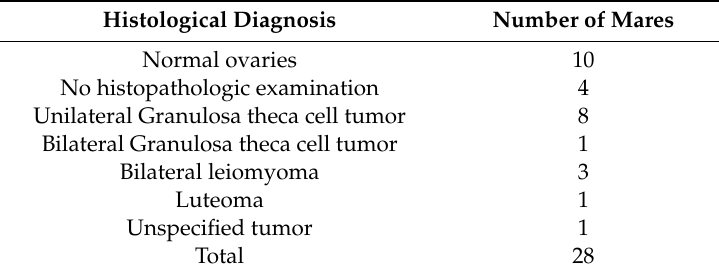
Table 1. Distribution of histopathologic findings.